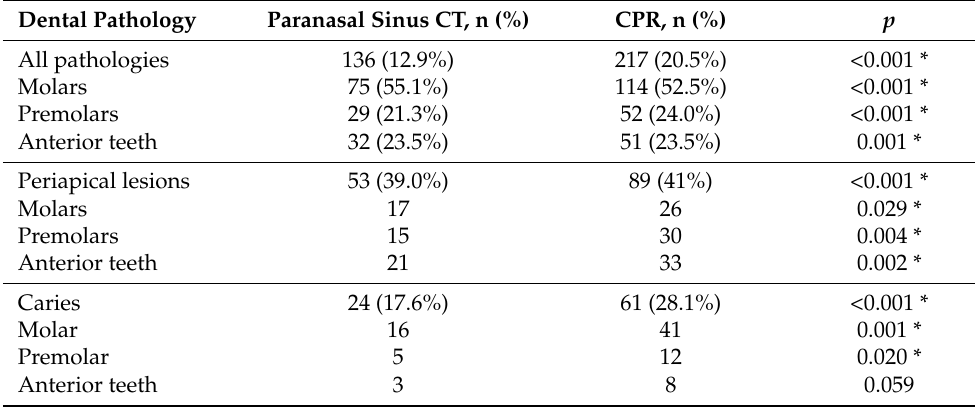
Table 2. Comparison of dental pathologies diagnosed by paranasal sinus CT and CPR in 1058 maxillary